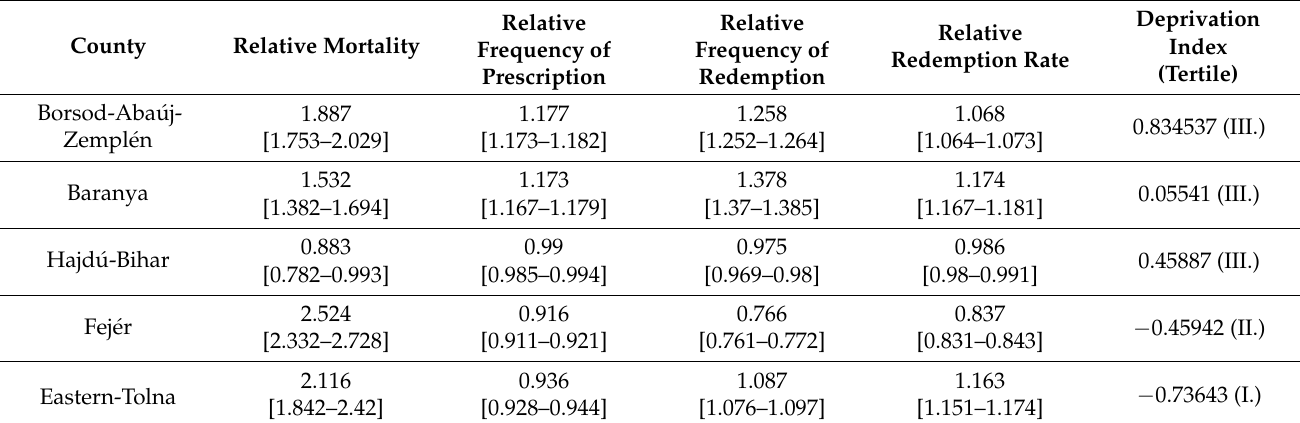
Deprivation Relative Relative Relative Frequency of Frequency of Redemption Rate (Tertile) Redemption Prescription